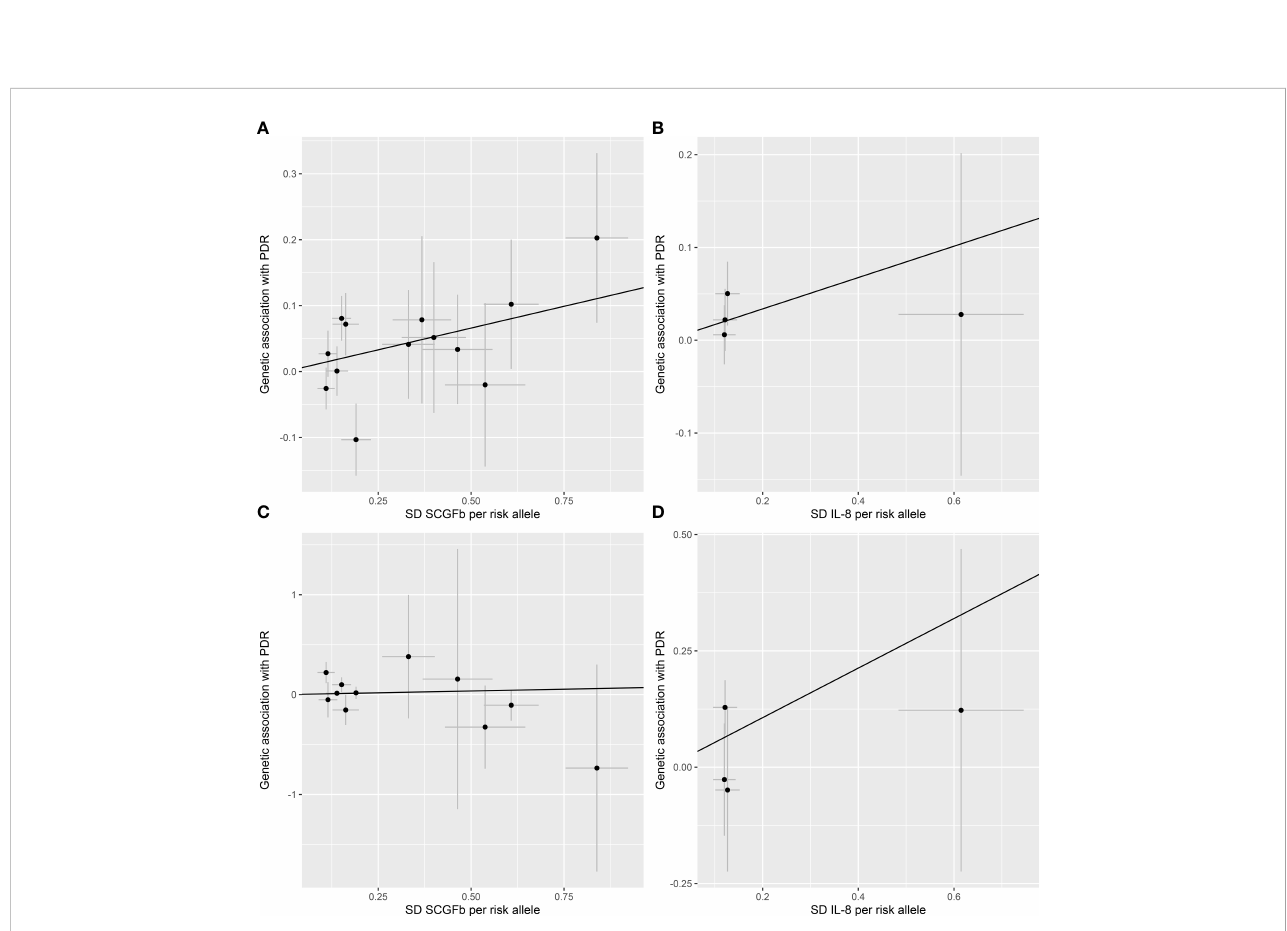
FIGURE 4 Scatter plot of SCGFb and IL-8 related SNPs with the risk of proliferative diabetic retinopathy. (A) Genetic association of SCGFb related SNPs and PDR from FinnGen. (B) Genetic association of IL-8 related SNPs and PDR from FinnGen. (C) Genetic association of SCGFb related SNPs and PDR from eight cohorts. (D) Genetic association of IL-8 related SNPs and PDR from eight cohorts. Black line indicates the estimate of effect using the inverse variance weighted method. Circles indicate marginal genetic associations with SCGFb or IL-8 and risk of outcome for each variant. Error bars indicate 95% con fi dence intervals. IL, interleukin; SCGFb, stem cell growth factor beta; SD, standard